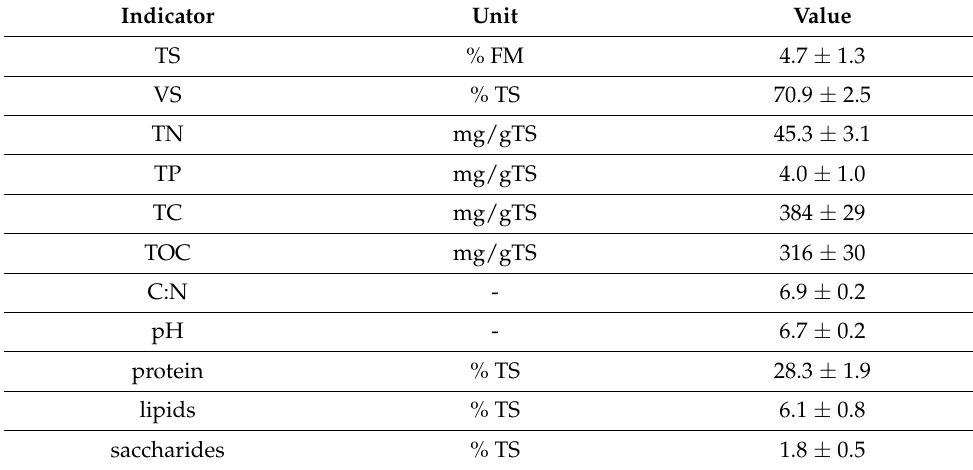
Table 2. Profile of the digester inoculum (anaerobic